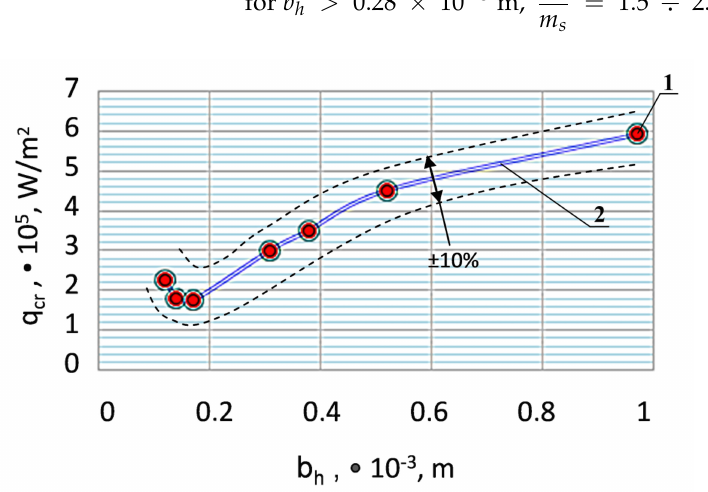
Figure 6. The dependence of the critical heat flow rate per unit area ( q cr ) on the mesh width ( b h ) during water boiling: 1—experiment; 2—calculations according to Equations (4) and